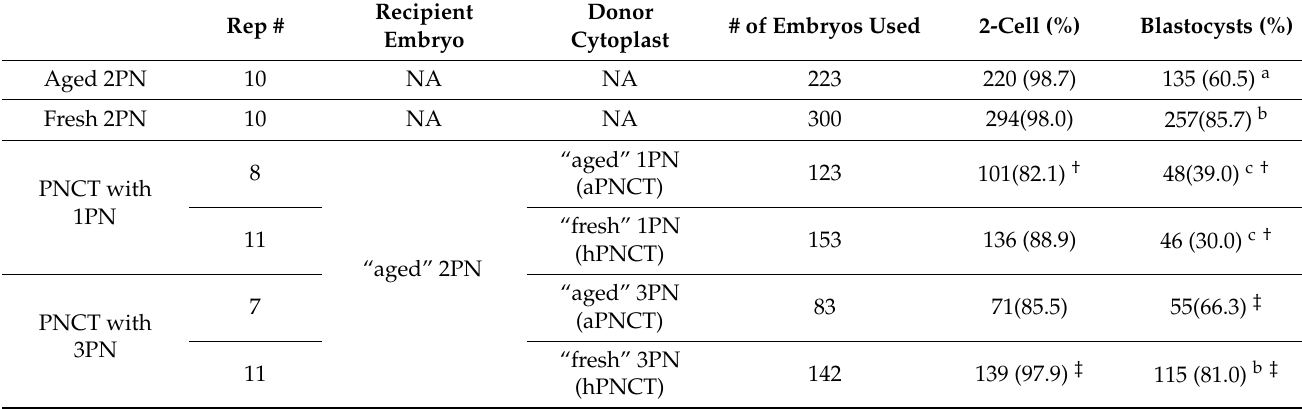
Table 1. In vitro development of nonmanipulated and PNCT